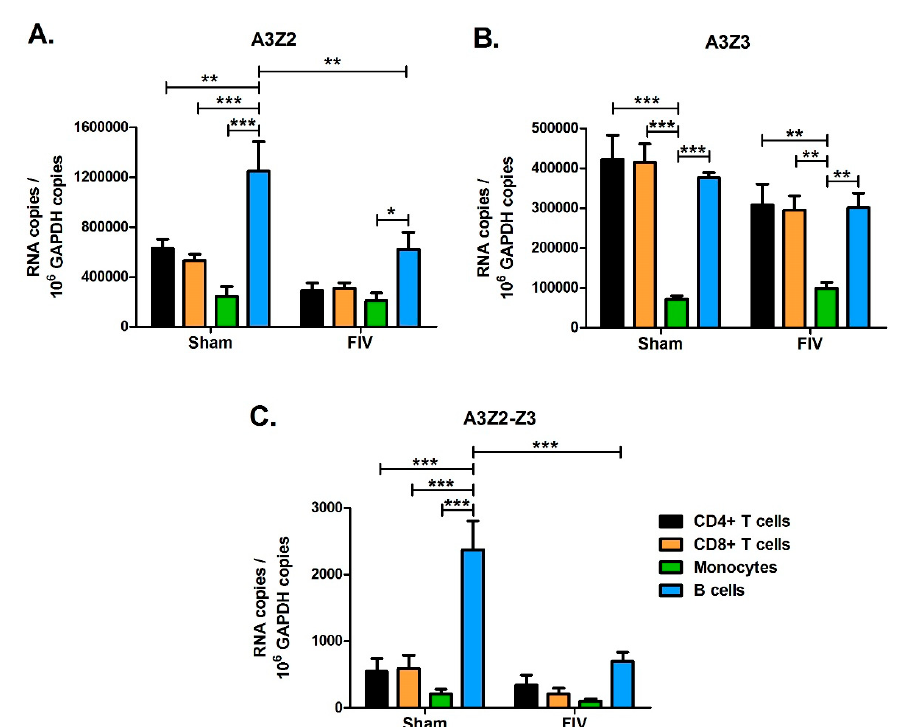
Figure 9. A3 expression patterns in leukocyte subtypes from FIV and Sham-infected cats. PBMCs were isolated from three chronically FIV-infected cats (18-weeks post infection) and cells were sorted by FACS into CD4 + , CD8 + , B cell (B220 + ), and monocyte (CD14 + ) subsets. Expression of A3Z2 ( A ), A3Z3 ( B ), and A3Z2-Z3 ( C ) mRNA was determined for each cell subset. Expression levels were compared between cell types, e.g., B cells versus monocytes, and between Sham- and FIV-infected animals within the same cell type, e.g., Sham B cells versus FIV B cells. Statistically significant group mean di ff erences are displayed for all significant comparisons (***, p < 0.001; **, p < 0.01; *, p < 0.05). Comparison of cell type indicated that B cells had higher A3Z2 and A3Z2-Z3 expression than T cells and monocytes, while monocytes had lower A3Z3 expression than lymphocytes. Comparison of Sham- and FIV-infected cats indicated that FIV-infected cats had lower A3Z2 and A3Z2-Z3 expression in B cells; all other di ff erences between Sham and FIV were not statistically significant. Error bars represent standard errors of the